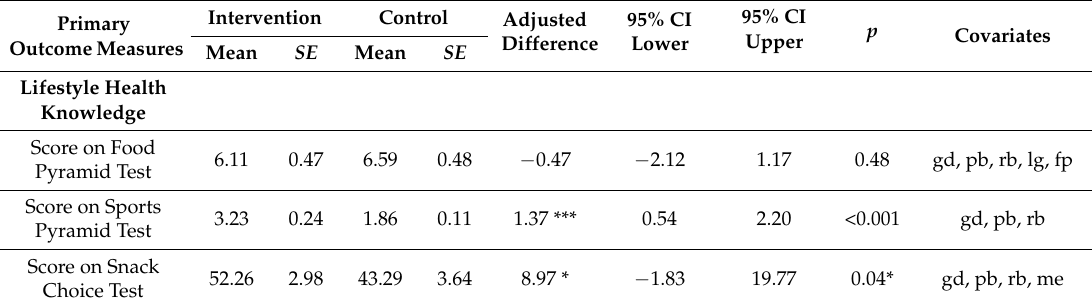
Table 3. Estimates of lifestyle health knowledge in complex sample general linear